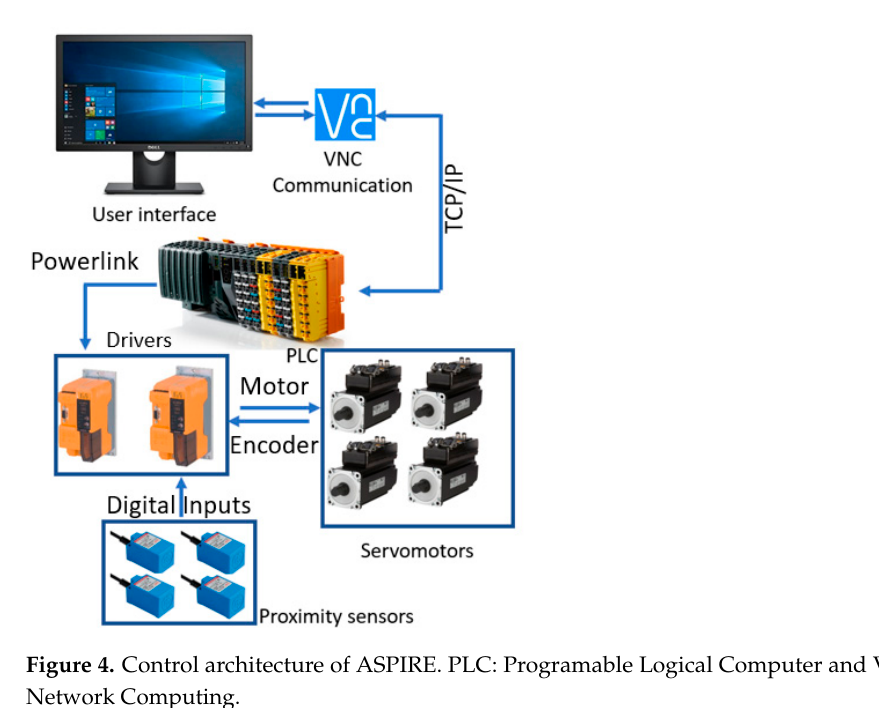
6 of 20 Figure 3. Initial experimental model of ASPIRE.